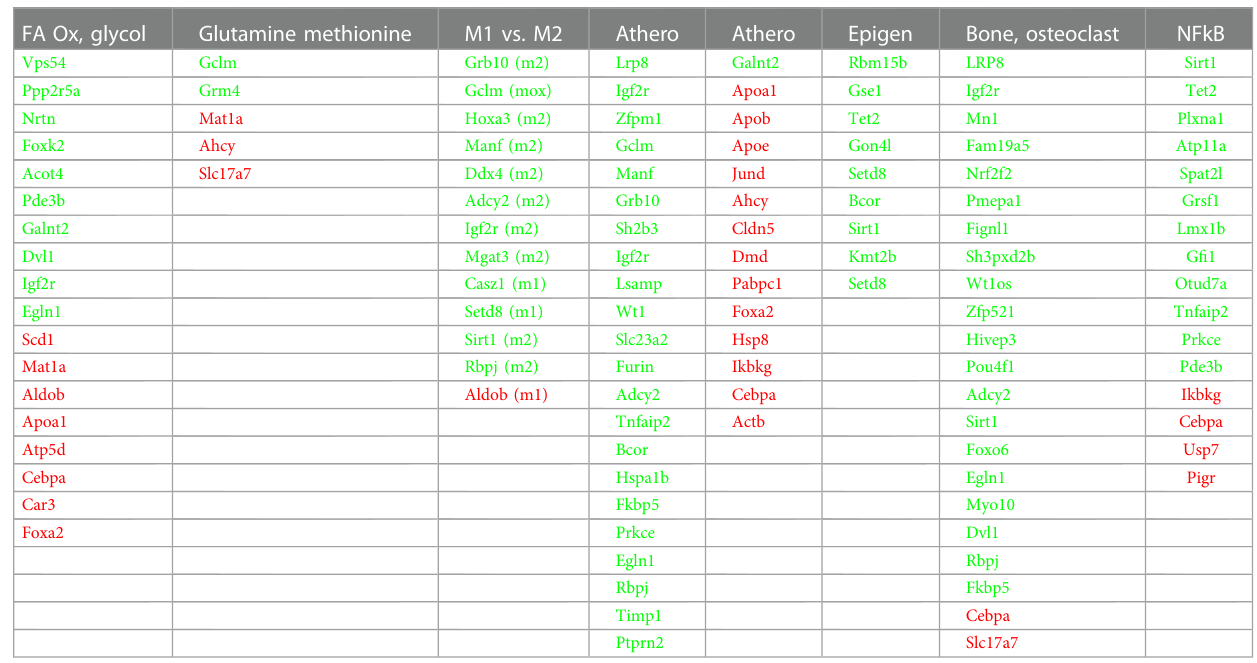
Green, hypomethylated; red, hypermethylated; FA Ox, fatty acid oxidation; Glycol, glycolysis; Athero, atherosclerosis; Epigen,